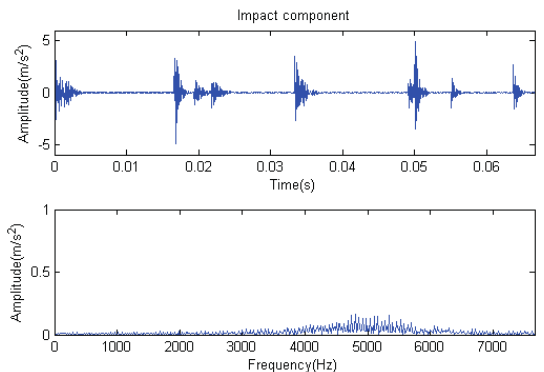
Figure 28. Impact component.